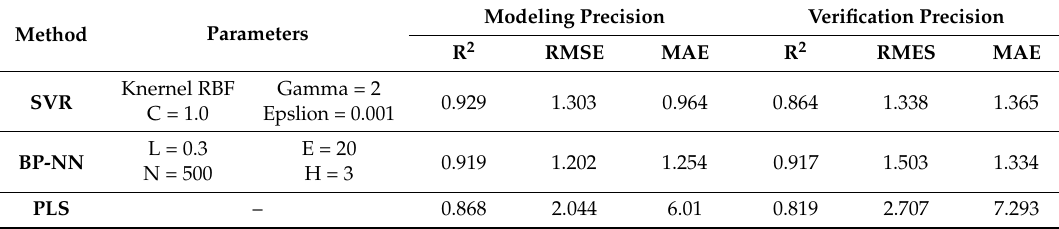
Table 6. Non-linear regression inversion models of SPAD based on UAV imagery.